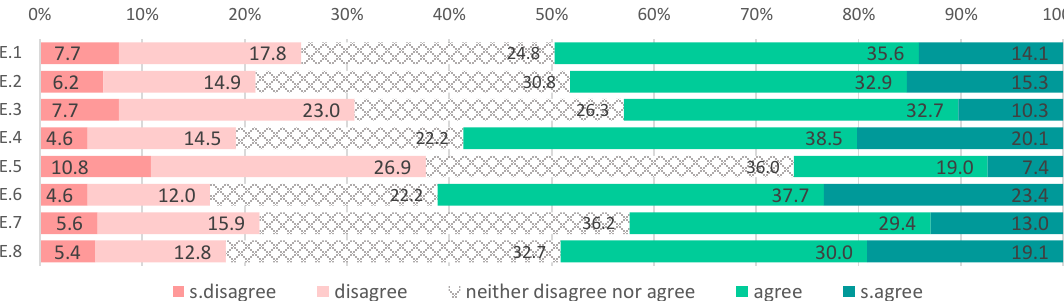
Figure 6. Reasons for reluctance to use IGS. (RE.1) I’m concerned about the conflict with the landowner of the site; (RE.2) signs or fences make it difficult to get into the site; (RE.3) risk of injury; (RE.4) there is a lot of trash inside; (RE.5) it seems to be polluted; (RE.6) it is not managed for use; (RE.7) it is too small or narrow to use; and (RE.8) it may be either developed or disappear